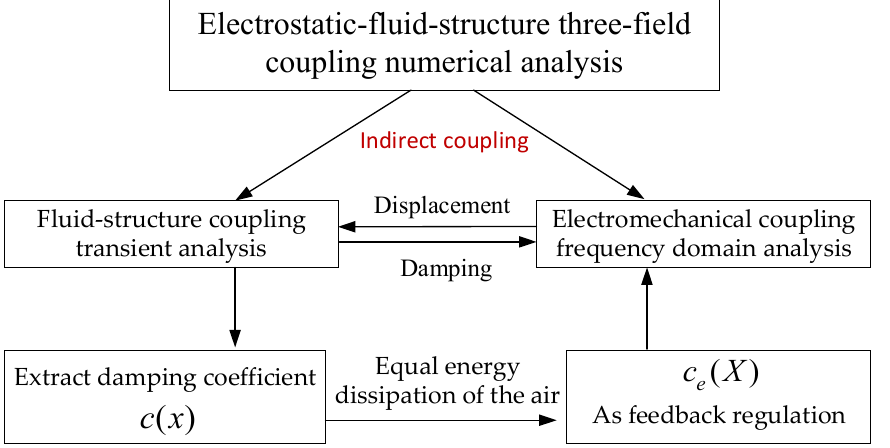
Figure 2. Schematic diagram of three-field coupling data transfer.